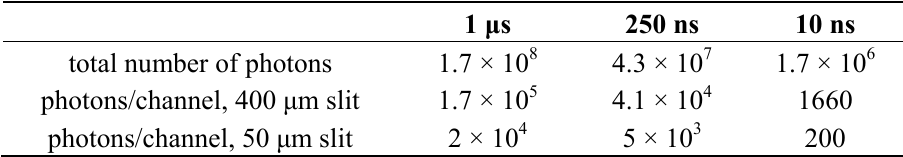
Table 3. Photons falling on the photocathode of the image intensifier, estimated from power measurements at the end of the 400 μ m fiber at the entrance of the photometer. Energy of a 500 nm photon is used for the calculations. Spectral resolution with 400 μ m slit is 12 nm, with 50 μ m slit is 3 nm. Photons/channel calculated from 1024 pixels in full vertical binning mode of the iStar